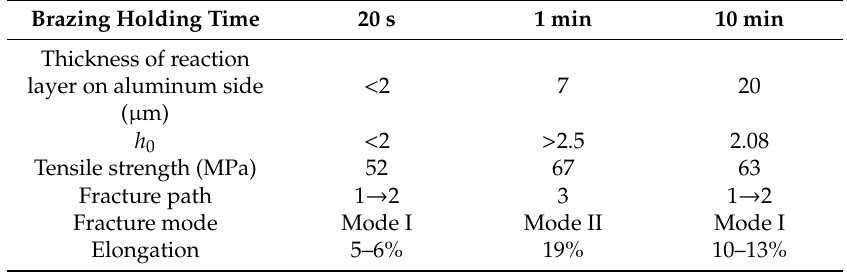
Table 5. Di ff erent mechanical parameters and fracture modes of the tension testing specimen under di ff erent brazing